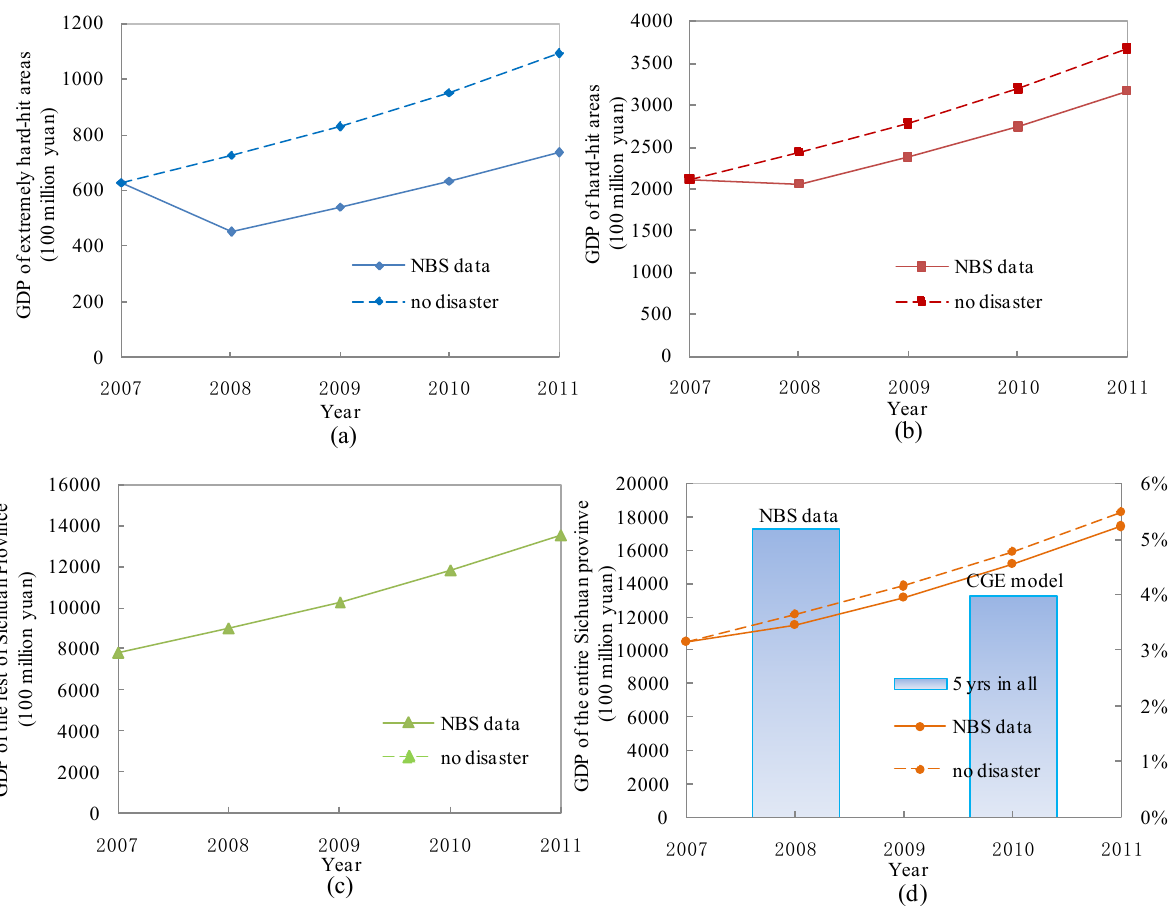
Fig. 7. Variations in Sichuan GDP, in percent of S 0 (no-disaster scenario) GDP based on NBS data and the CGE model.